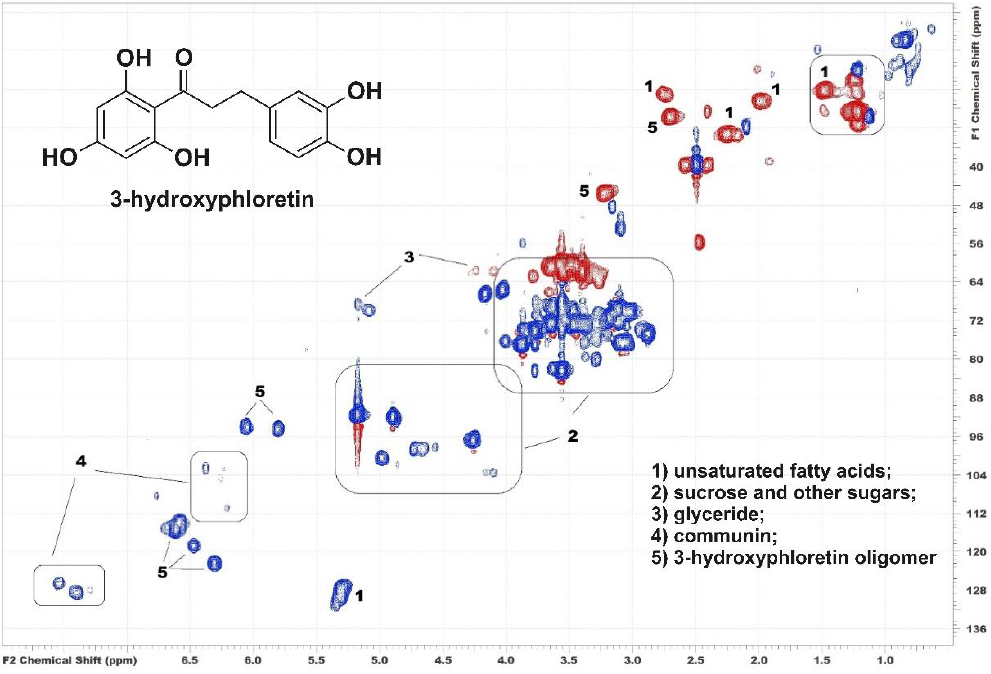
Figure 1. 1 H- 13 C HSQC NMR spectrum of acetone extract of P. commune and assignment of the main cross-peaks.